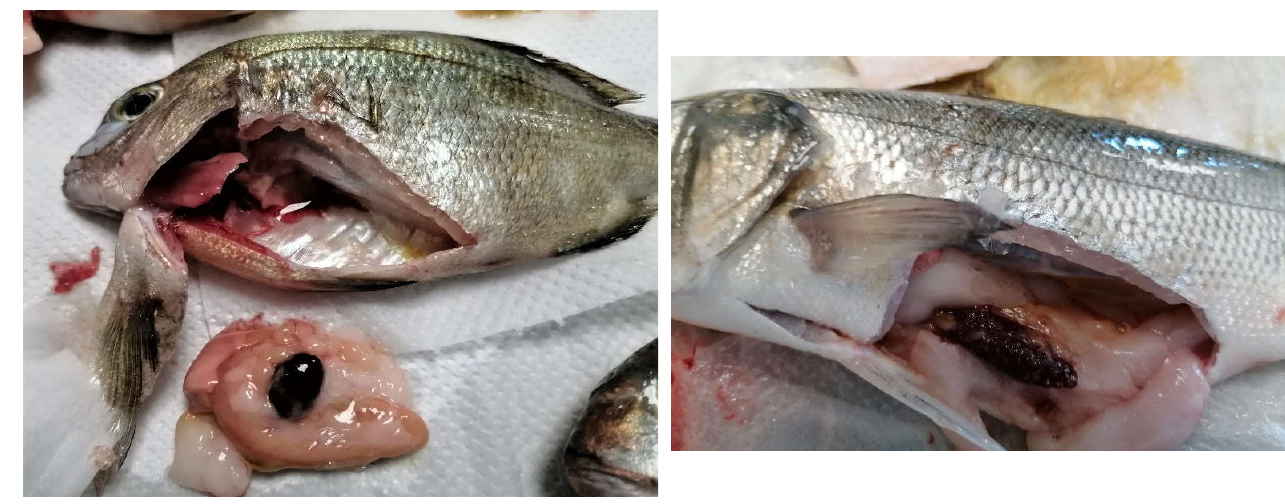
Figure 3. Splenomegaly in red porgy ( Pagrus pagrus ) ( left ) and sea bass ( Dicentrarchus labrax ) ( right ). All but one strain isolated in TSA agar were identified as Photobacterium damselae sbsp. piscicida (Table 1) using both applied techniques. Maximum likelihood phylogenetic analysis of the 16S rRNA segment demonstrated only two haplotypes identical with already available P. damselae sbsp. piscicida and P. damselae sbsp. damselae haplotypes in the GenBank database (Figure 4, Supplementary file). These results confirmed the molecular identification of the cultured bacteria as P. damselae sbsp. piscicida and P. damselae sbsp. damselae (Table 1).